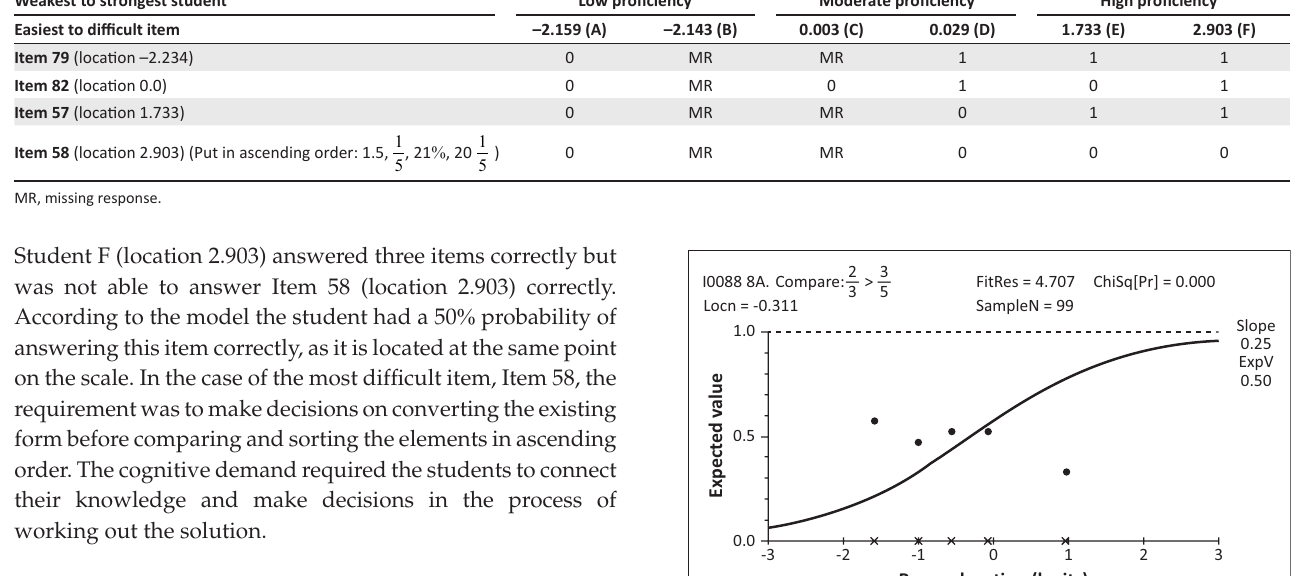
TABLE 2: Six students, low, moderate and high proficiency vs performance on four items. Weakest to strongest